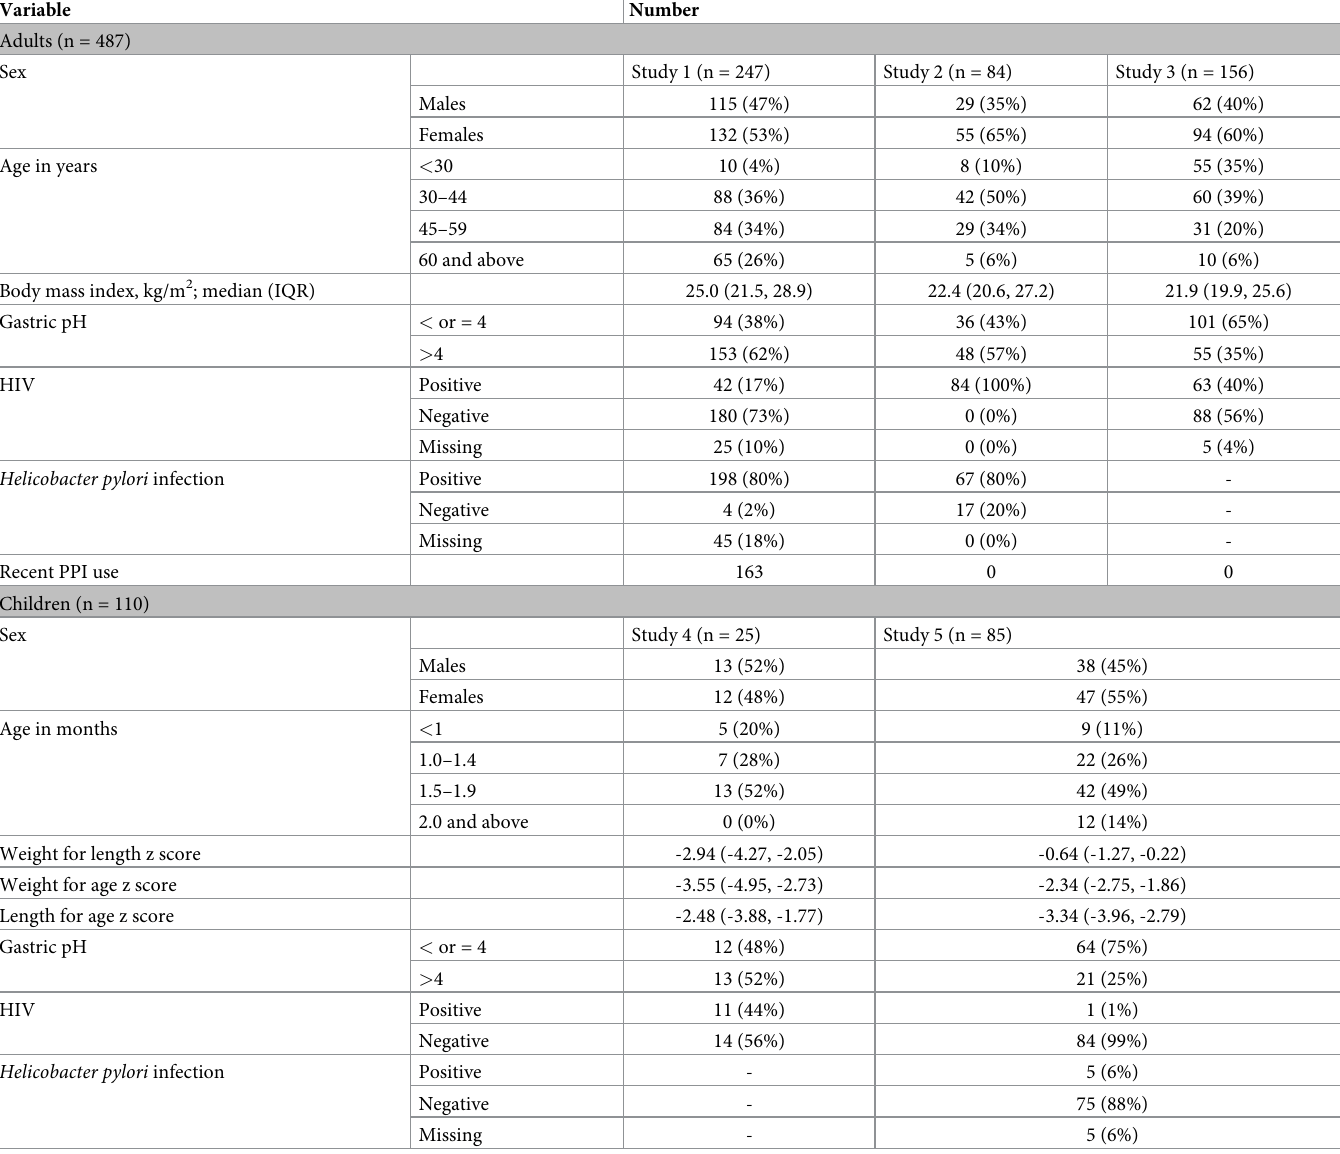
Table 1. Patient characteristics of adults and children included in the